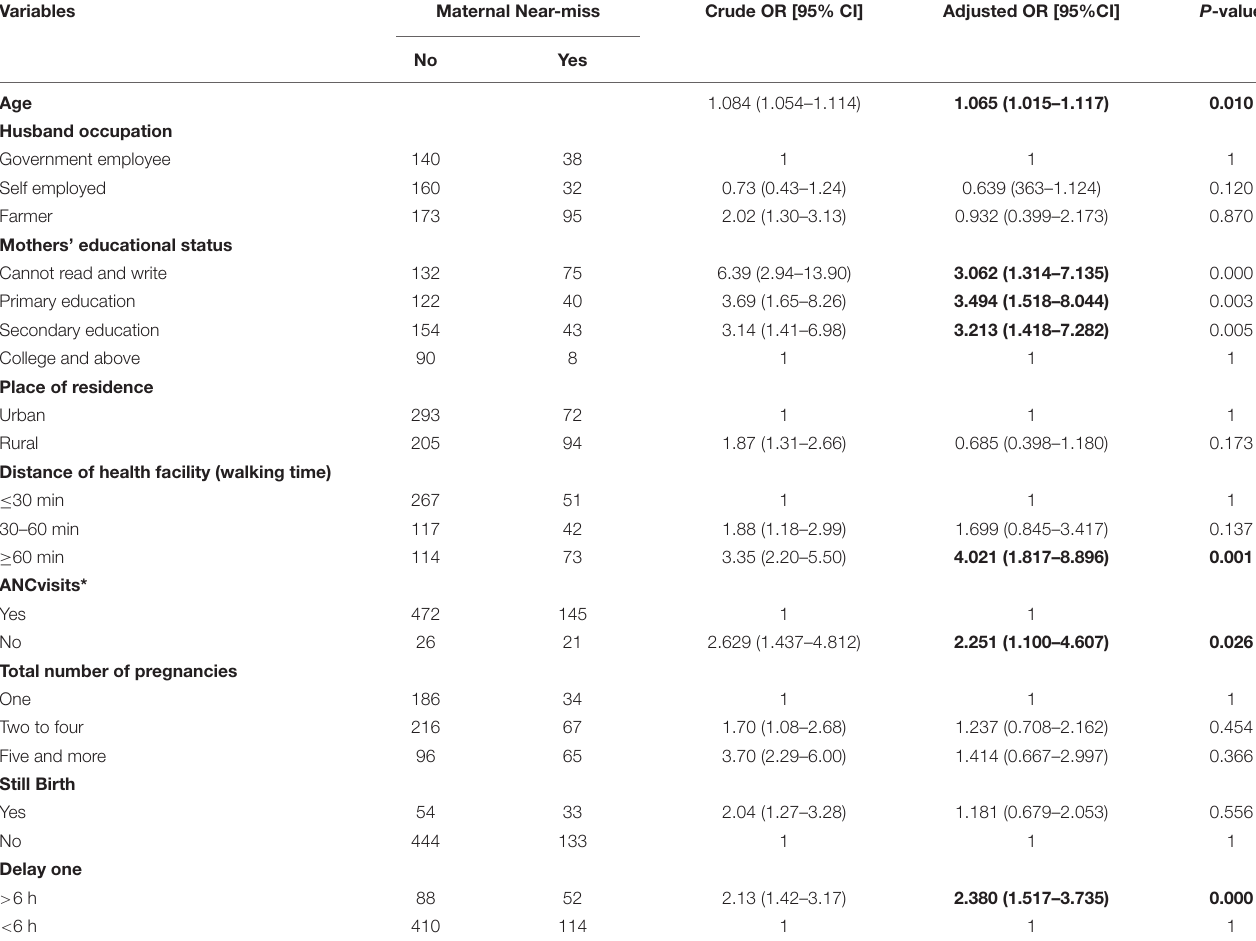
TABLE 4 | Bivariate and multivariable analysis of maternal near-miss predictors in West Shoa zone public hospitals, Central Ethiopia, 2020. Variables Maternal Near-miss Crude OR [95%